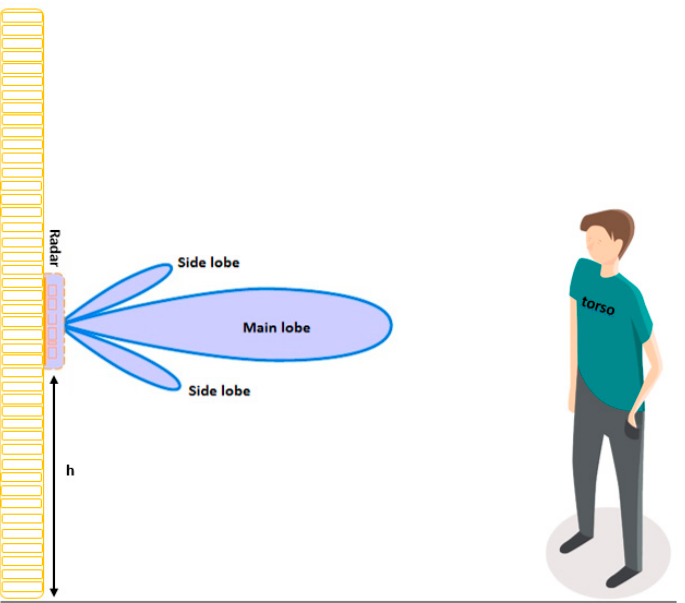
Figure 5. Proper radar position for gait monitoring using a single radar sensor (the main beam illuminates the walking person’s torso).